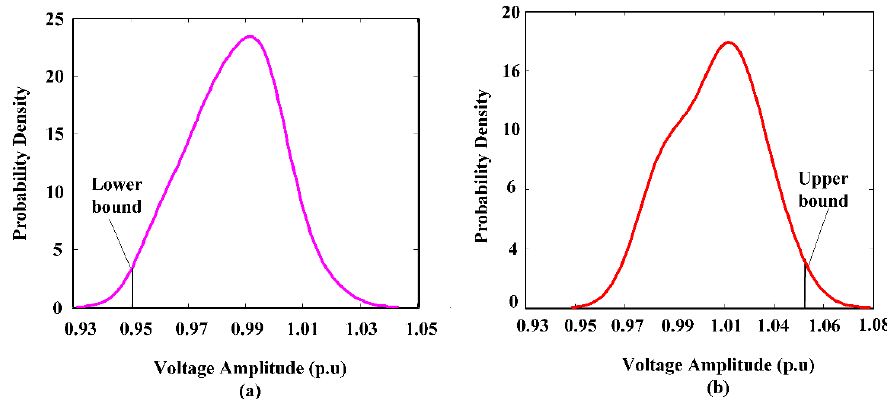
Figure 9. PDF curve of voltage amplitude in Scenario A of 69 ‐ bus system: ( a ) Node 50 and ( b ) Node 14.